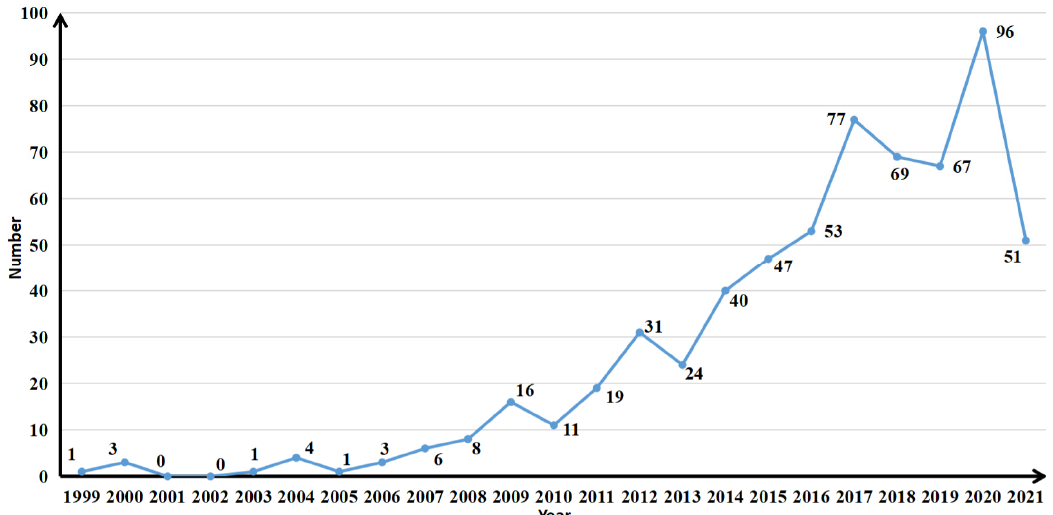
Figure 1. Number of articles published annually on the theme of land use change and food